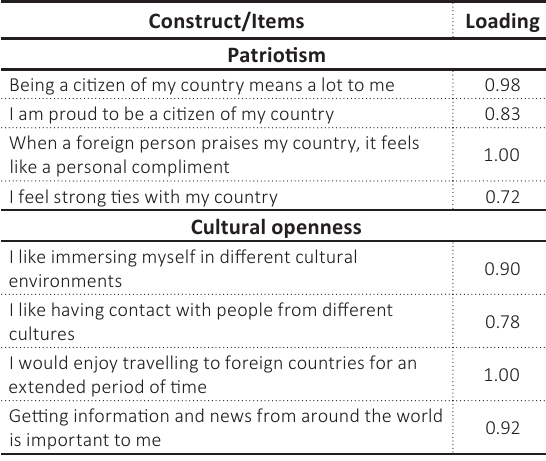
Table 2. Confirmatory factor analysis results